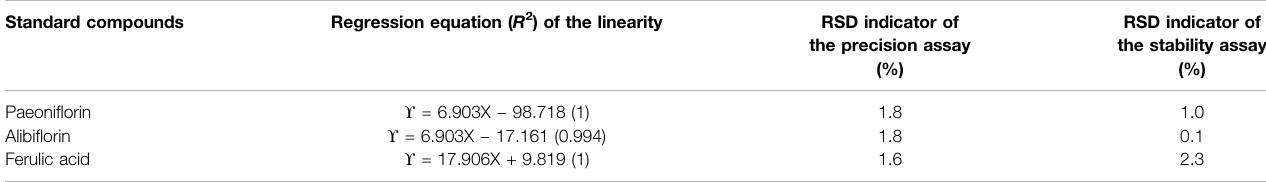
Correlation coef fi cients, R . 2 .